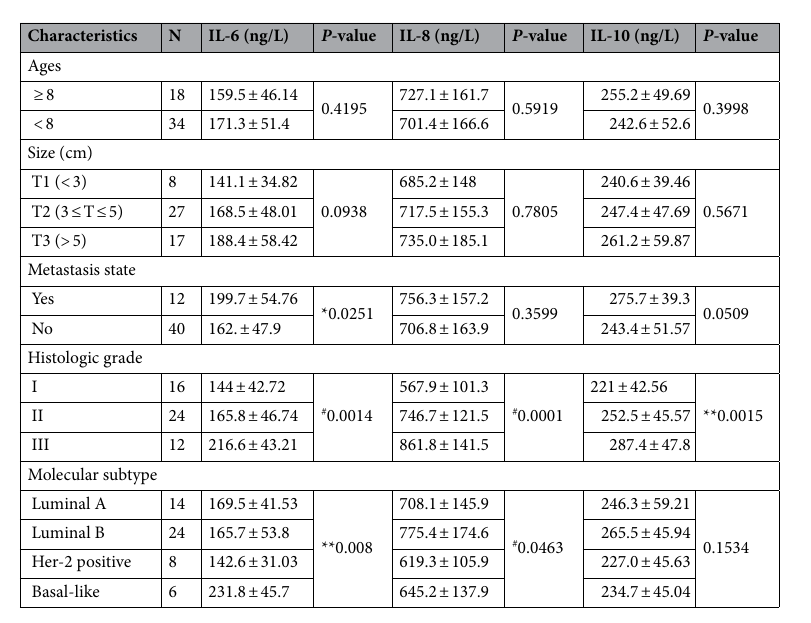
Figure 1. Serum levels of IL-6, IL-8 and IL-10 in CMGTs and healthy dogs. The serum levels of IL-6 ( A ), IL-8 ( B ) and IL-10 ( C ) in CMGTs and healthy dogs were detected by ELISA assay. One-way analysis of variance (ANOVA) by Tukey’s multiple comparison test was used to analyze multiple group comparisons data. The results from three independent experiments are presented as the mean ± standard deviation (SD). *denotes P < 0.05 and **denotes P < 0.01 compared with the healthy canine mammary gland serum group.